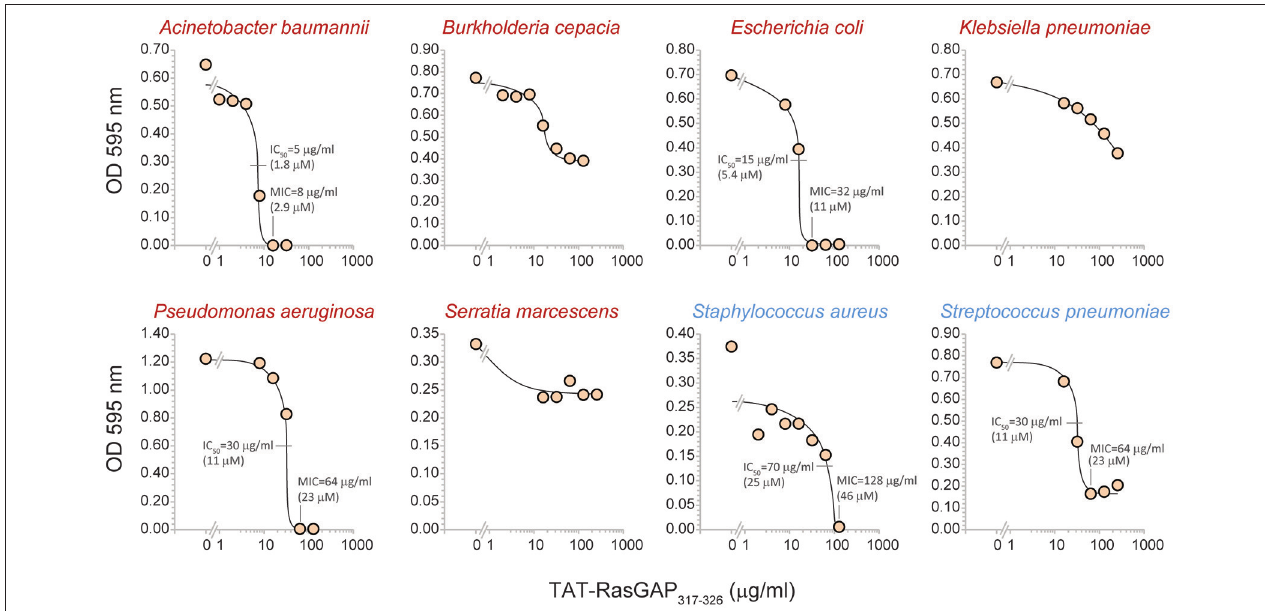
FIGURE 2 | TAT-RasGAP 317 − 326 -mediated growth inhibition of ATCC bacteria. The indicated bacteria strains obtained from ATCC were grown in appropriate media in the presence of the indicated concentrations of TAT-RasGAP 317 − 326 . The OD 595nm was measured after 16h of incubation at 37 ◦ C. IC 50 , fifty percent maximal inhibitory concentration; MIC, Minimal inhibitory